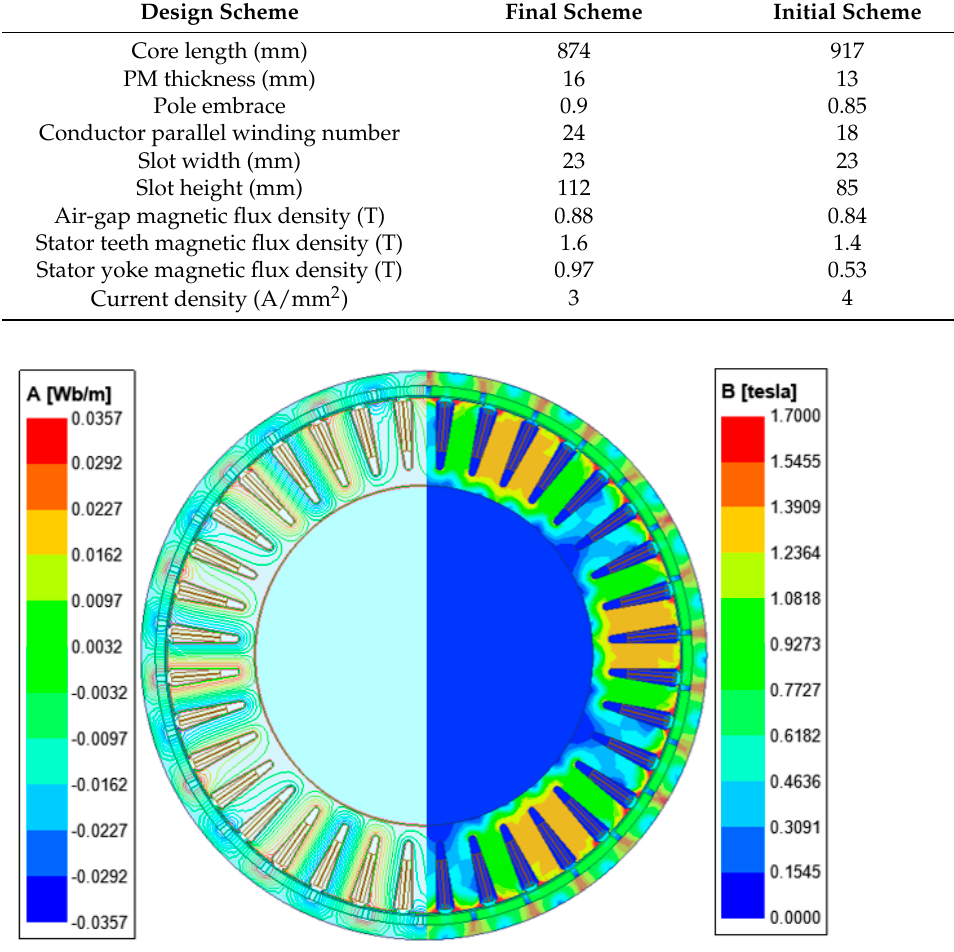
Figure 18. The magnetic flux density distribution of the final scheme. The core loss and eddy current loss of the PM in the final scheme at rated load are shown in Figure 19. After entering the steady state, the average core loss of the final scheme is 4870 W, the average eddy current loss of the PM is 602 W, and the average copper loss is 8655 W. Compared with the initial scheme, the core loss of the final scheme increases by 1122 W, caused by the increase in magnetic load. In addition, due to the reduction in current density and core length of the final scheme, the copper loss has dropped by 3775 W. The eddy current loss of the PM has not changed substantially in two schemes. Figures 20 and 21 show the temperature distribution and comparison at rated load for the final and initial schemes. Compared with the initial scheme, since the copper loss of final scheme decreases more than the stator core loss increases, the temperature of each part of the motor has dropped considerably in the final scheme. The temperature of the stator winding part has dropped the most, reaching 21 ◦ C. Therefore, in the design of outer rotor LSPMMs, lower current density and higher magnetic load can effectively improve temperature characteristics and reduce the size of the